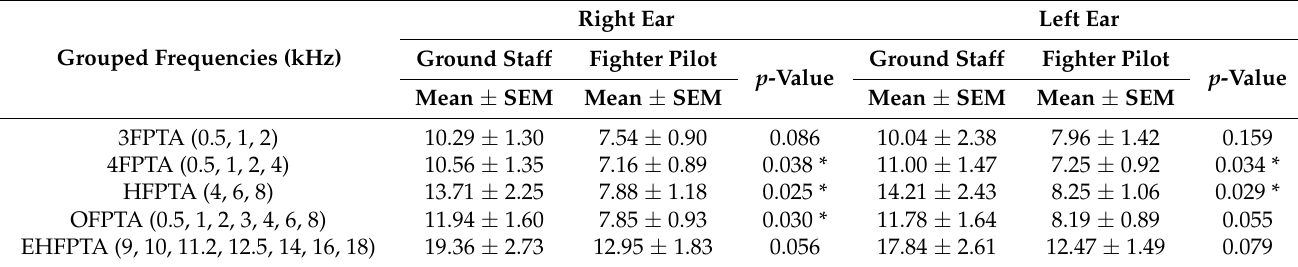
OFPTA (0.5, 1, 2, 3, 4, 6, 8) EHFPTA (9, 10, 11.2, 12.5, 14, 16,